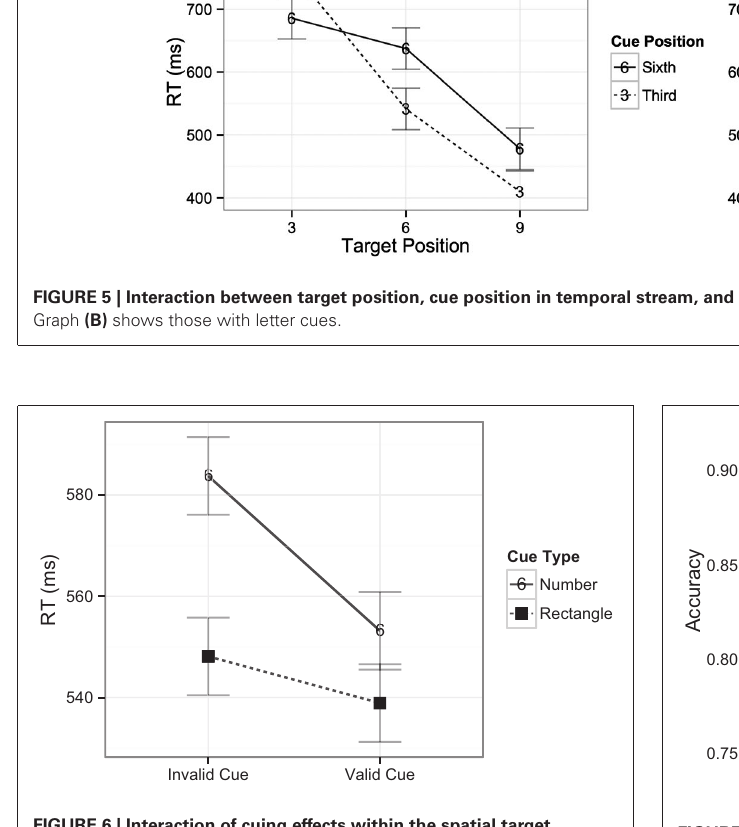
FIGURE 7 | Accuracy across the spatial target detection